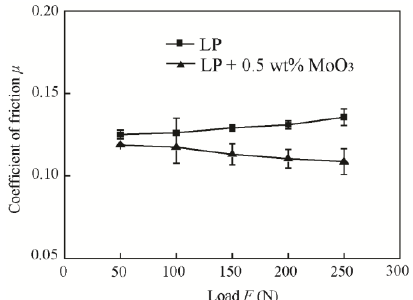
Figure 9. Friction coefficients of base oil and with 0.5 wt % micro-lamellar MoO 3 additives under different loads.